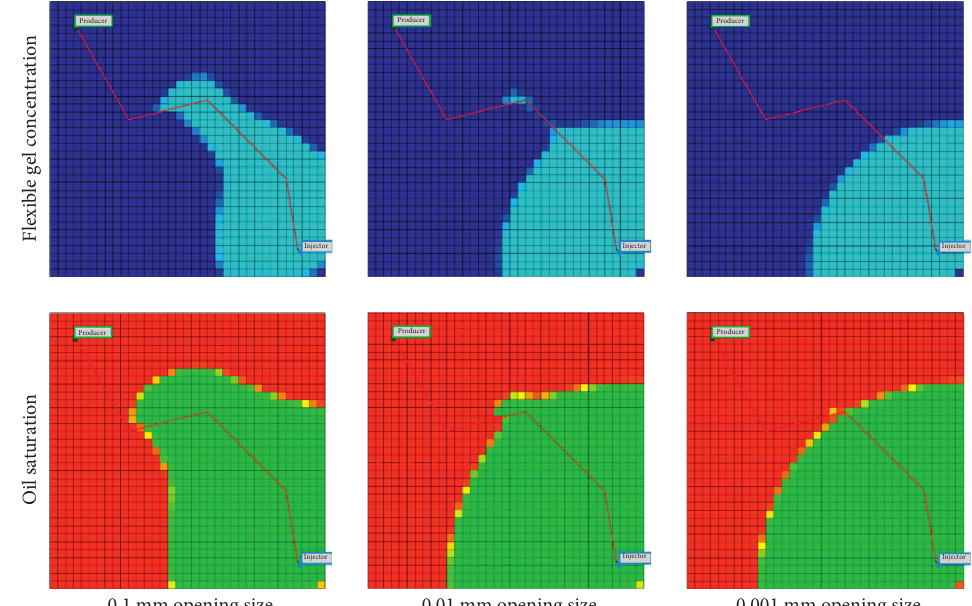
Figure 12: Distribution of chemical agent concentration and oil saturation after control and flooding with flexible gel in fractured reservoirs with variable opening sizes.